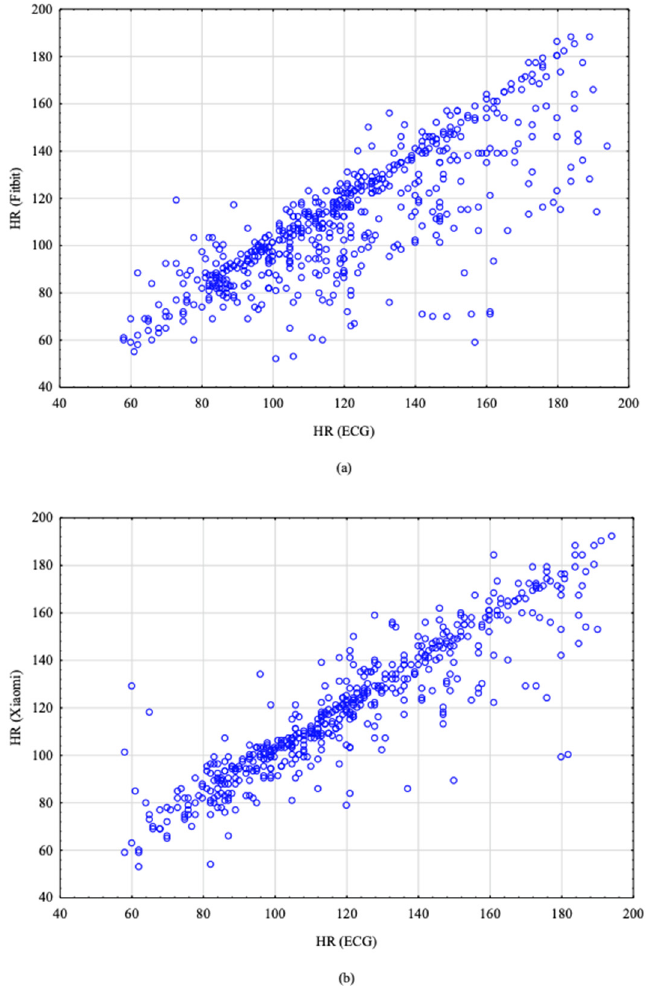
Figure 1. Scatterplots of pairs of HR measurements. ( a ) HR readings obtained from the ECG and Fitbit; ( b ) HR readings obtained from the ECG and Xiaomi. Table 4. Lin’s concordance correlation coefficient (LCCC).